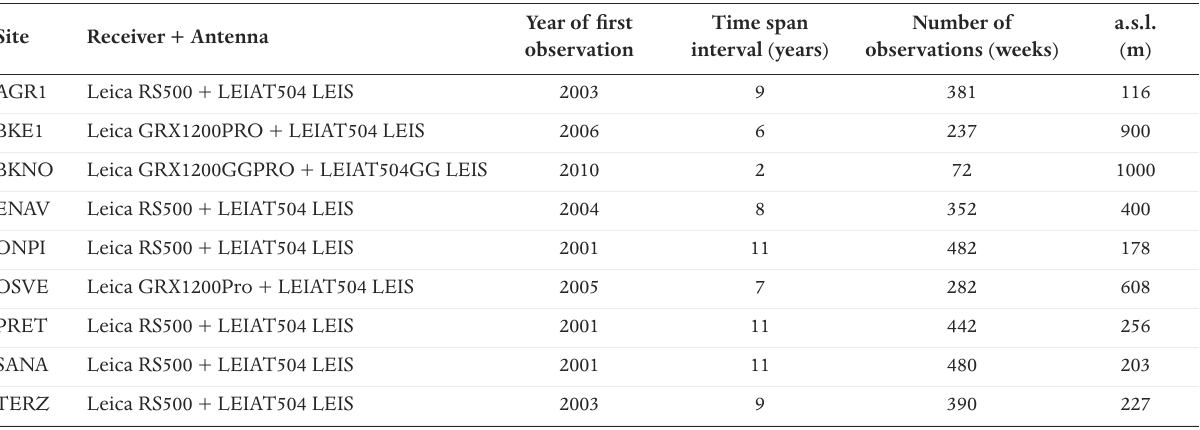
Table 1. Characteristics of the CGPS stations used in this paper and of the collected data. Station TERZ was equipped with choke ring an- tenna in 2003 and due radiofrequency interference first observation of OSVE started in